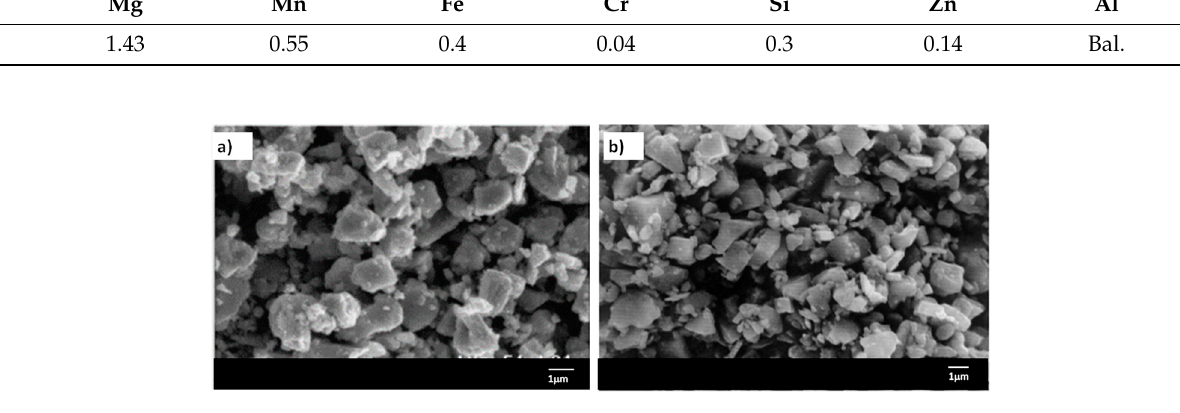
Table 1. Chemical composition of the Al-2024 alloy (wt.%).